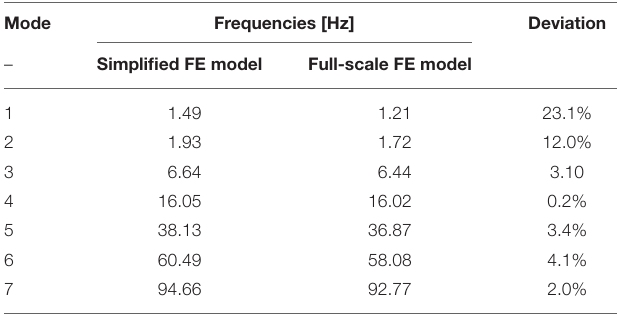
TABLE 4 | Comparison between modal frequencies of the simplified FE model at idle state and the full-scale FE model. Mode Frequencies [Hz]